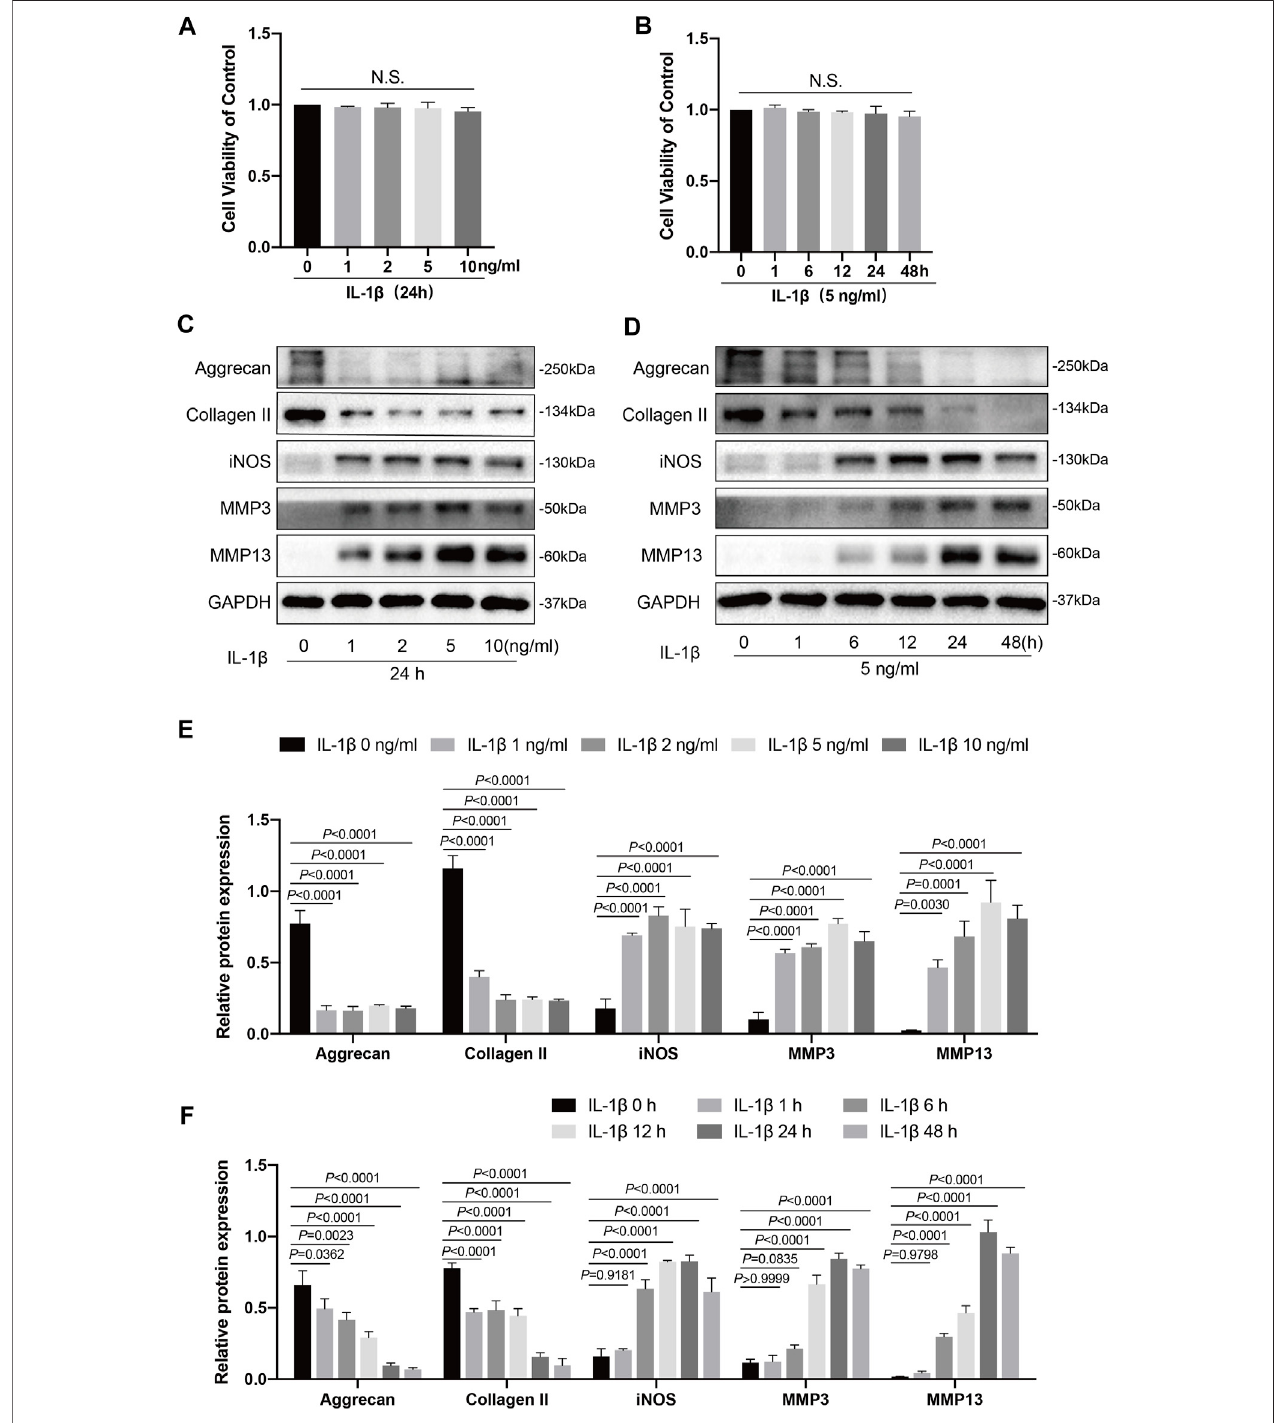
FIGURE1| EffectsofIL-1 β onkneechondrocytesinmice. (A) Micechondrocytes weretreatedwithvariousconcentrationgradientsofIL-1 β (0,1,2,5,and10 ng/ ml) for 24 h, (B) or with IL-1 β at the concentration of 5 ng/ml for different time points (0, 1, 6, 12, 24, and 48 h), and cell viability was detected with a CCK-8 kit. (C) Western blots and (E) quantitative analysis of aggrecan, collagen II, iNOS, MMP3, and MMP13 for chondrocytes exposed to different concentrations of IL-1 β (0, 1, 2, 5, and 10 ng/ml) for 24 h. (D) Western blotting results and (F) quantitative analysis of aggrecan, collagen II, iNOS, MMP3, and MMP13 for chondrocytes stimulated with IL-1 β (5 ng/ml) at several time points (0, 1, 6, 12, 24, and 48 h). GAPDH was used as an internal reference. Data are presented as means ± SD ( n (cid:1) 3). The exact p value was marked in the corresponding fi gure, N.S. indicated no signi fi cance, and p < 0.05 was considered statistically signi fi cant.